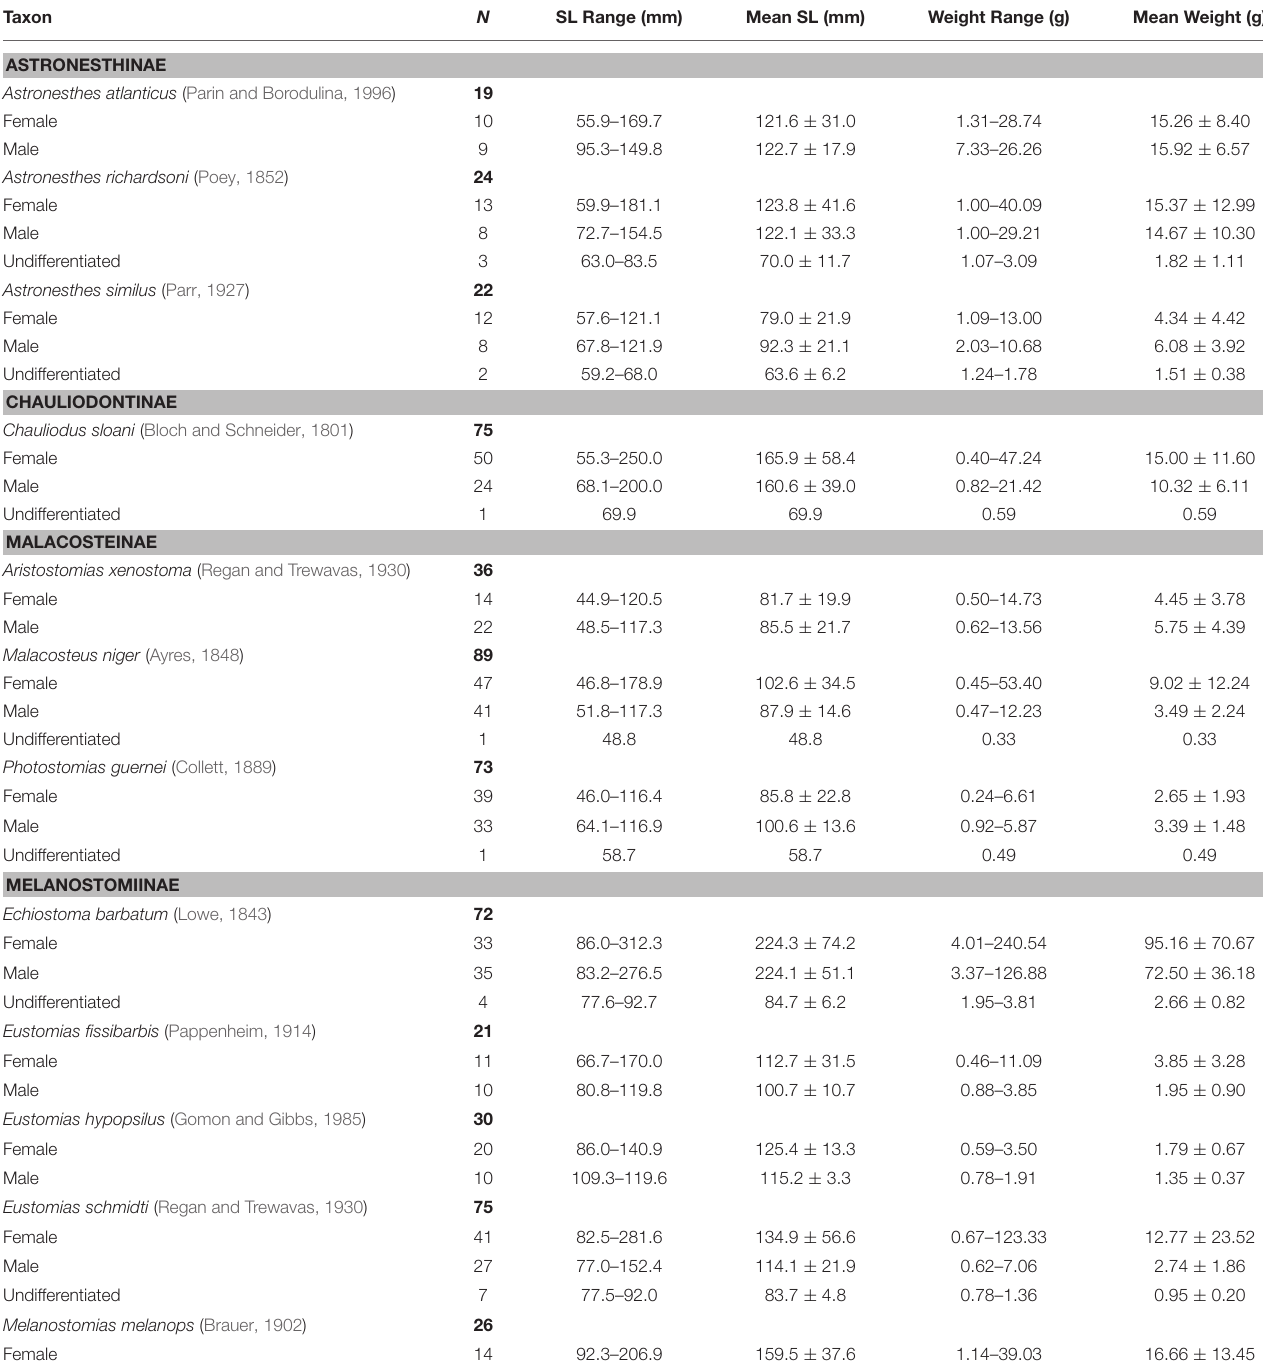
TABLE 2 | Count, size range, mean standard length (SL), and standard deviation, range of wet weight, and mean wet weight and standard deviation of 12 dominant stomiid species collected in the Gulf of Mexico between 2010 and